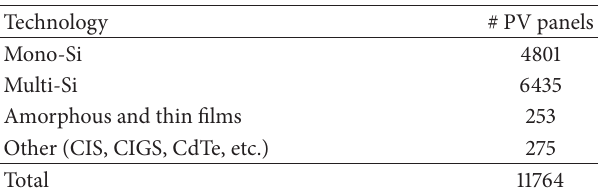
Table 2: Results obtained with Matlab fsolve for 𝑅 guess 𝑆